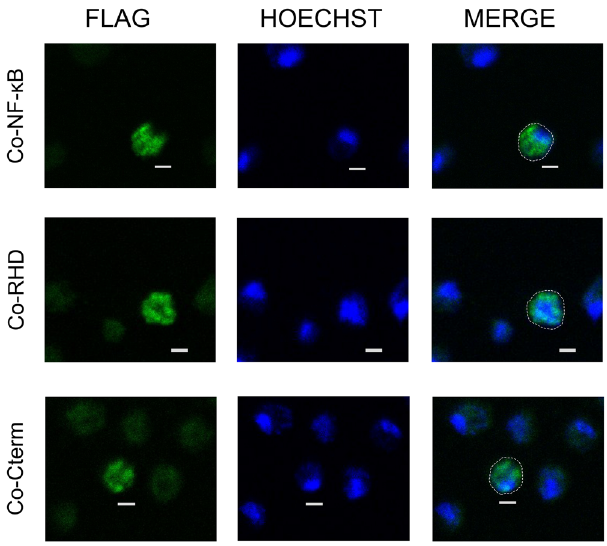
Fig. 4 Transfection of FLAG- Co -NF- κ B, FLAG- Co -RHD, and FLAG- Co - Cterm into Capsaspora cells results in cytoplasmic localization. Capsaspora cells were transfected with FLAG-tagged vectors for full-length Co -NF- κ B, mutant Co -RHD, and mutant Co -Cterm. The cells were stained using anti-FLAG antiserum (left panels) and Hoechst (middle panels), and then merged (right panels). Scale bars are 2 µ m. The dotted white lines indicate the periphery of the